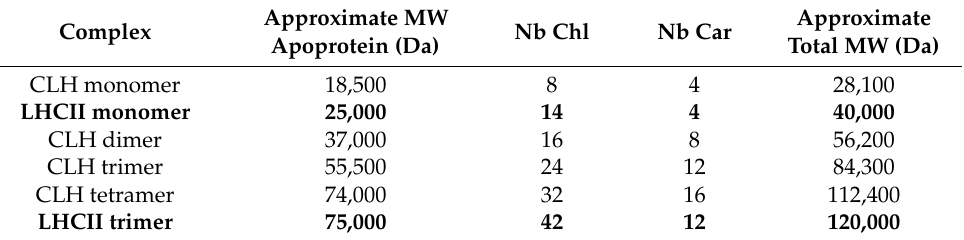
Table 3. Theoretical comparison of the sizes of LHCII and CLH oligomers. Calculation of the approximate molecular weight (MW) of different CLH oligomers, compared to LHCII monomers and trimers. For LHCII, we considered an averaged MW of 25 kDa for the apoprotein, as well as 14 Chl and 4 carotenoids per monomer, of an average MW of 900 and 600 Da, respectively. For CLH, the MW of the apoprotein presented here is the average of the 18 and 19 kDa proteins composing the purified antenna band [32]. We counted a theoretical 8 Chl and 4 Car per monomer, from bibliographic sources (see Introduction). Lipids were not considered, due to lack of information on CLH antennas. Approximate Approximate MW Nb Chl Nb Car Complex Total MW (Da) Apoprotein (Da) CLH monomer 18,500 8 4 28,100 LHCII monomer 25,000 14 4 40,000 CLH dimer 37,000 CLH trimer 55,500 CLH tetramer 74,000 32 112,400 LHCII trimer 75,000 42 12